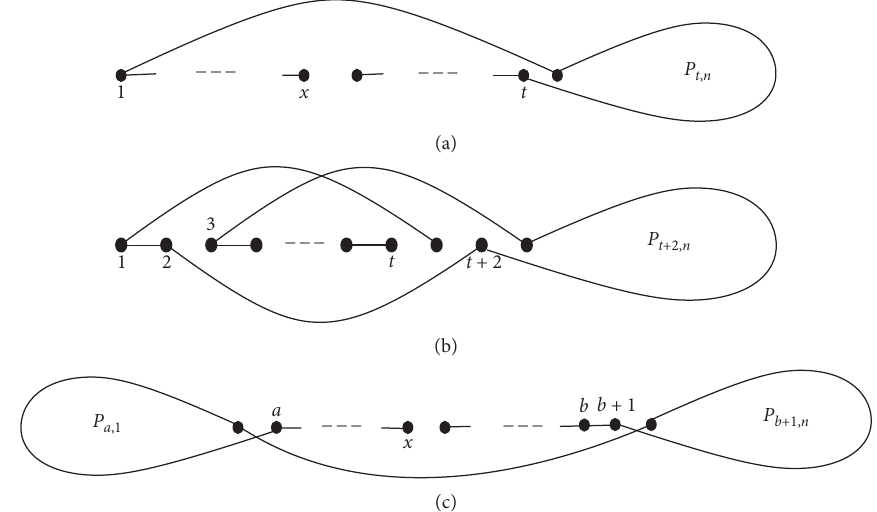
Figure 3: Hamiltonian path from x to x + 1 in T when x ≤ ⌈ n /2 ⌉ . (a) x ≤ t − 1. (b) x � t . (c) y � x +1 for x > t .